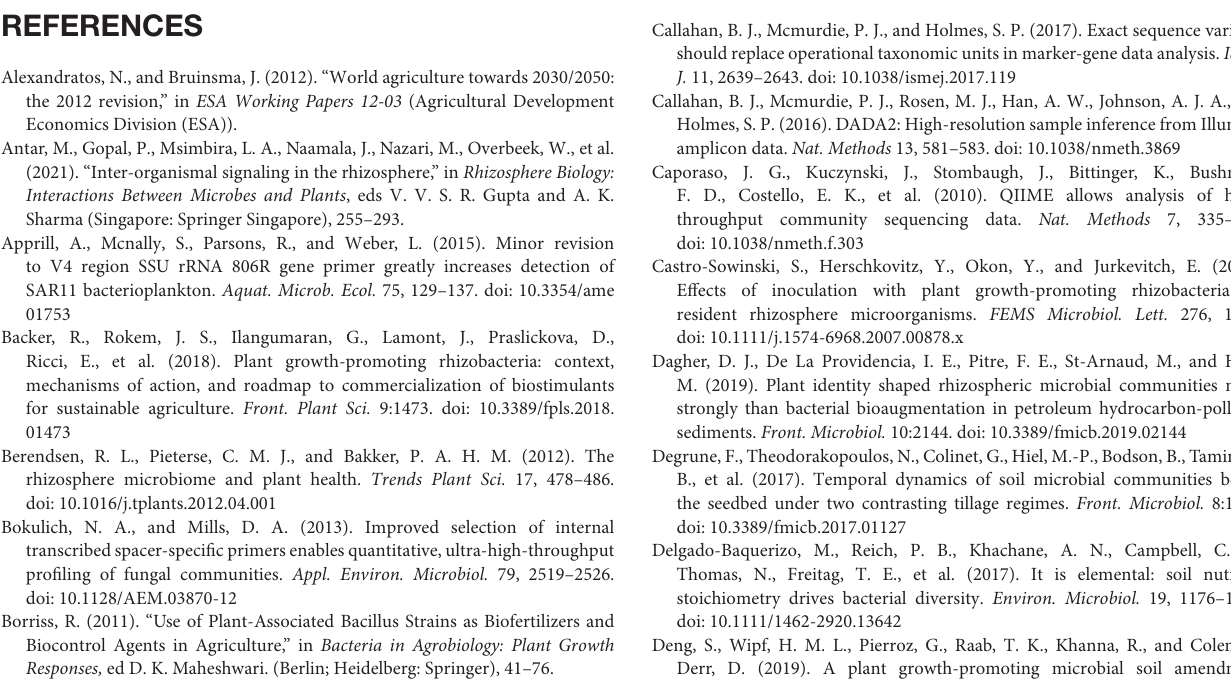
Supplementary Figure 1 | Principal coordinates analysis (PCoA) of prokaryotic (A) and fungal (B) communities in bulk soil samples. PCoAs were based on Bray-Curtis distance at the ASV level.